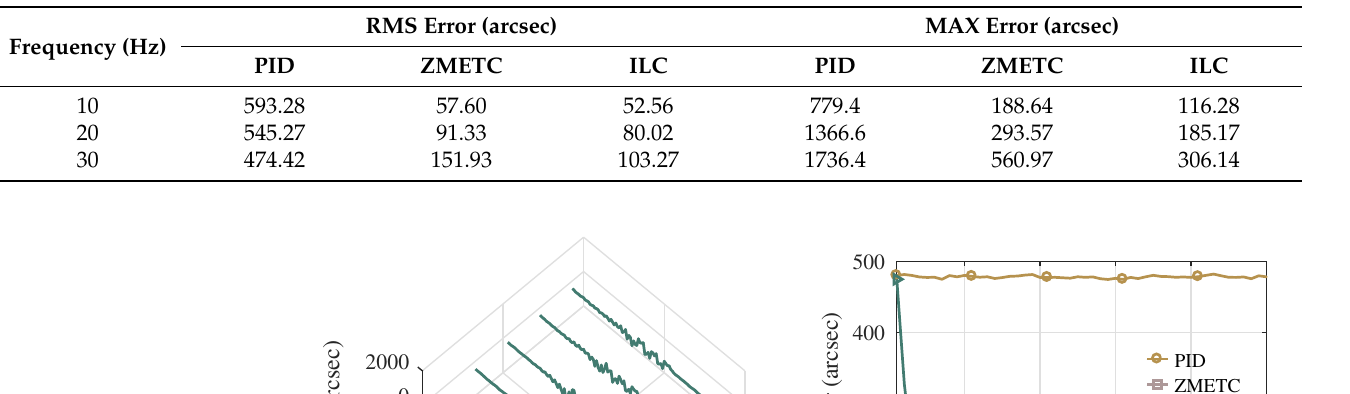
Table 1. Error results of triangular reference tracking.